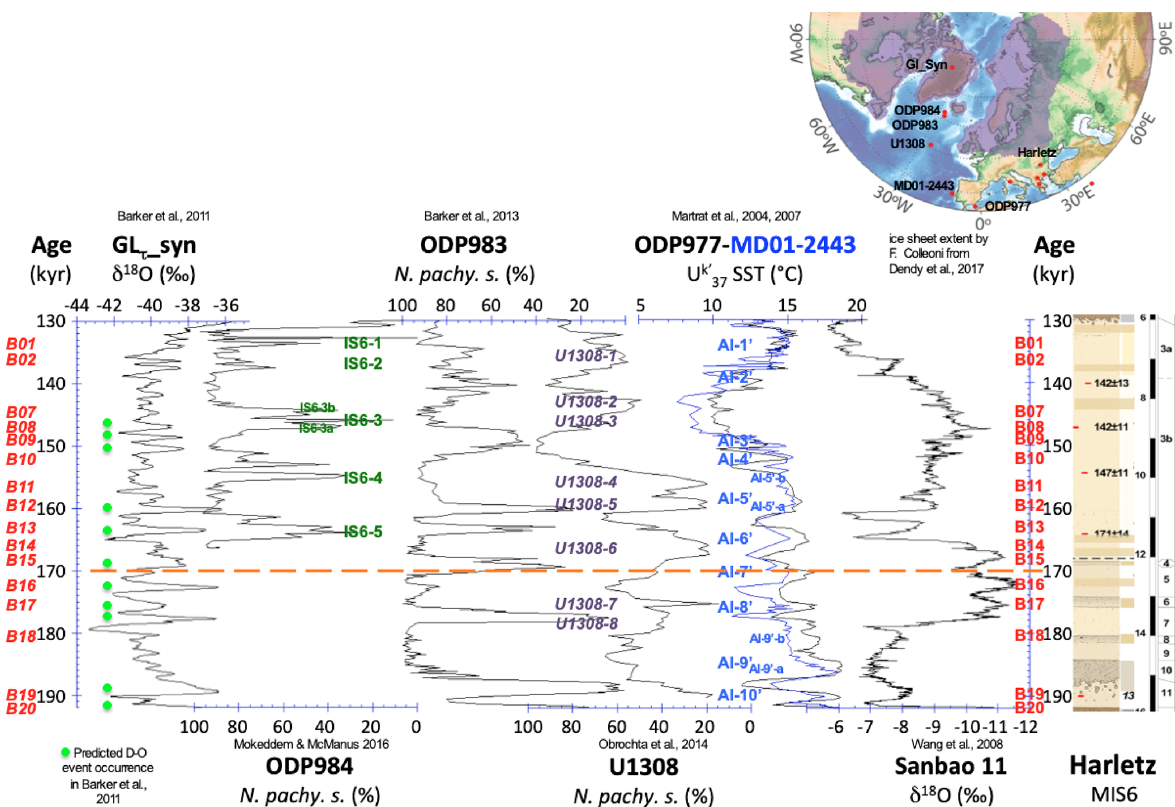
Figure 4. Comparison of Northern Hemisphere records of MIS 6. Greenland synthetic δ 18 O (Barker et al., 2011), North Atlantic SST ( N. pachyderma s.) (cores ODP 984, Mokeddem and McManus, 2016; ODP 983, Barker et al., 2015; U1308, Obrochta et al., 2014a, b), Iberian margin and Alboran Sea SST (alkenone MD01-2443, ODP 977; Martrat et al., 2004a, b, 2007a, b), and Chinese speleothem δ 18 O (Sanbao11; Wang et al., 2008). Labels of the interstadials are as identified in the marine and speleothem records. Green dots denote predicted DO event occurrence from Barker et al. (2011). The pedostratigraphy of the Harletz MIS 6 record is added with the newly described paleosols and pedogenic horizons for comparison. Complementary labels assign warm events to the ODP 984 (IS6-3a, b), U1308 (1–8), and ODP 977/MD01-2443 (AI-5’a, b; AI-9’a, b) North Atlantic and Mediterranean MIS 6 records used in Table 1. MIS 6 ice sheet extent by Florence Colleoni in Dendy et al.